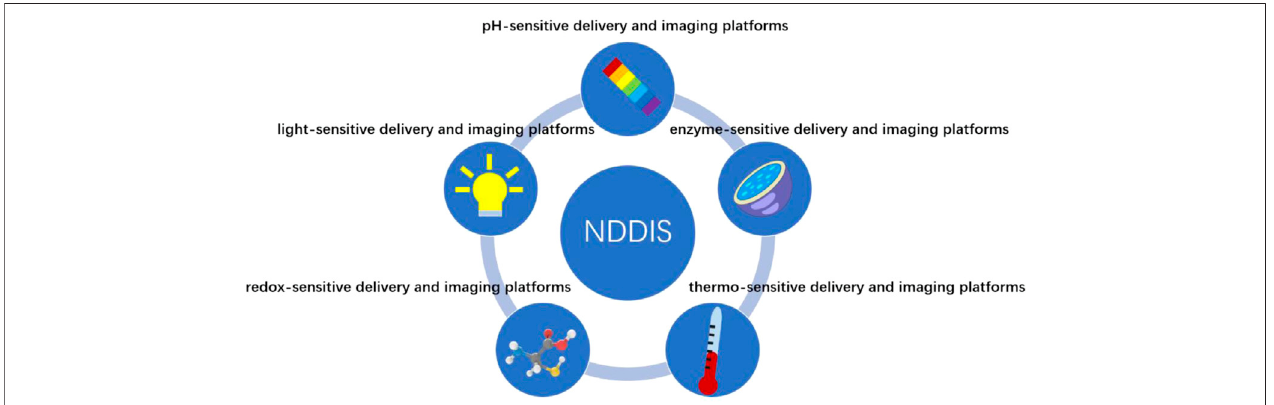
FIGURE1| Graphicalsummarizationof fi vedifferenttypesofstimuliputintothedesignofstimuli-sensitivenanocarriersfordrugdeliveryandimagingplatforms:pH- sensitivedeliveryand imagingplatforms, enzyme-sensitive delivery andimagingplatforms,thermo-sensitivedeliveryand imagingplatforms,redox-sensitivedeliveryand imaging platforms, and light-sensitive delivery and imaging